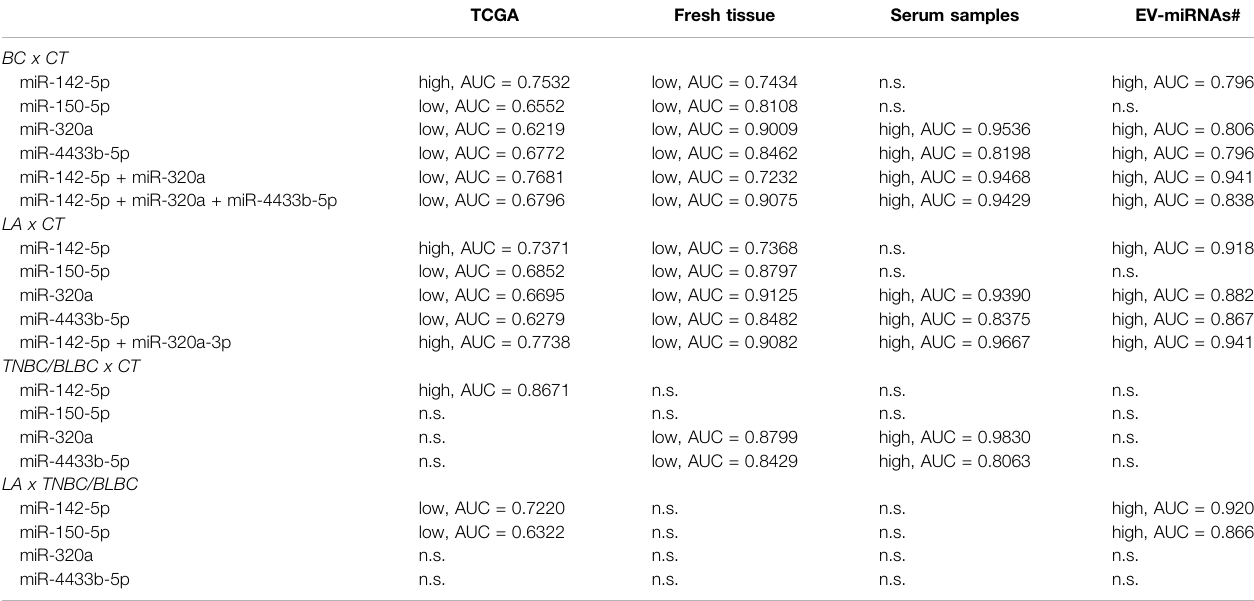
TABLE4| Comparison oftheexpression levelandperformanceofmiR-142-5p,miR-150-5p,miR-320a,andmiR-4433b-5pintissueandserumsamples(cell-freemiRNAs and